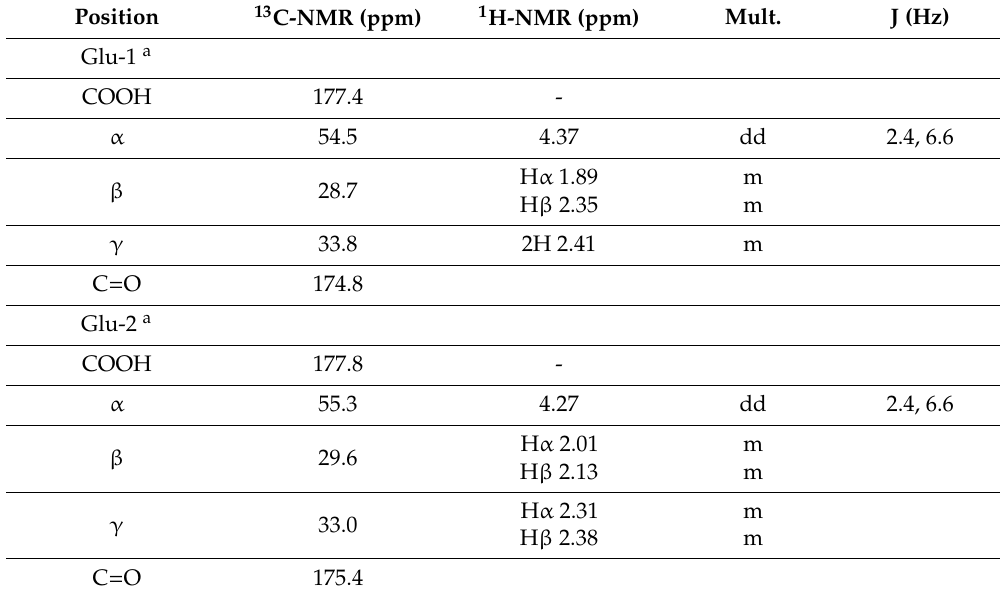
Table 2. 1 H-NMR (800 MHz) and 13 C-NMR (200 MHz) for cnidarin 4A ( 1 ) in CD 3 OD. Position 13 C-NMR (ppm) 1 H-NMR